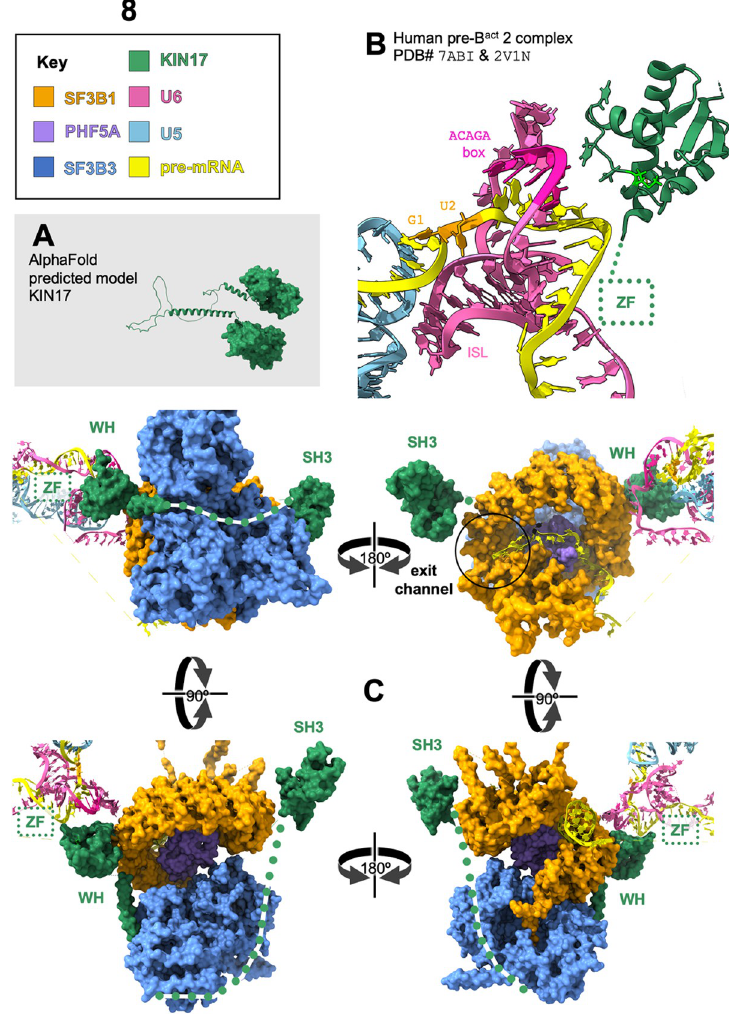
Fig 8. KIN17 touches 3 regions of preB act 2 spliceosome with possible regulatory roles. (A) Alpha Fold predicted model of KIN17 includes two globular domains connected by alpha-helices and unstructured regions. (B) A model of human pre-B act 2 complex of the splicing cycle, based on Protein Data Bank structures 7ABI [15] (positions of proteins and RNAs) with the addition of the aligned detailed structure of the loop that KIN17(M107I) resides on from PDB ID# 2V1N [25]. Colors are as noted in the key. KIN17 is near the U6/pre-mRNA helix. The pre-mRNA intron is unstructured behind KIN 17. Methionine 107 (spring green) is part of a short 3 10 helix, on a loop between two alpha- helices of the winged-helix, and the residue points into the globular core of the winged-helix domain away from the pre-mRNA. The 23rd residue of KIN17 is not modeled in this or any structure; for zinc finger structure prediction see Fig 2B. The dashed box shows the author-proposed location for this domain, near the internal stem-loop (ISL) of U6, an important component of the eventual active site. (C) Pre-B act 2 spliceosome in four orientations, colors as noted in key, with author-proposed regions shown as dotted lines. The winged-helix of KIN17 is modeled to the closed hinge of SF3b1 (HEAT repeats 15 and 16), the unmodeled zinc finger is proposed to be near the pre-mRNA U6 helix, the disordered central domain of KIN17 is proposed to loop around SF3b3, the tandem of SH3 domains is modeled on the far side of SF3b1, occluding the binding location of Prp2 (see S4 Fig for Prp2 binding in activated B act ). In the upper right orientation, the pre-mRNA branchpoint, colored black, is encircled within SF3b1, the downstream pre-mRNA is visible exiting SF3b1 via the “exit channel” inside black circle on the upper